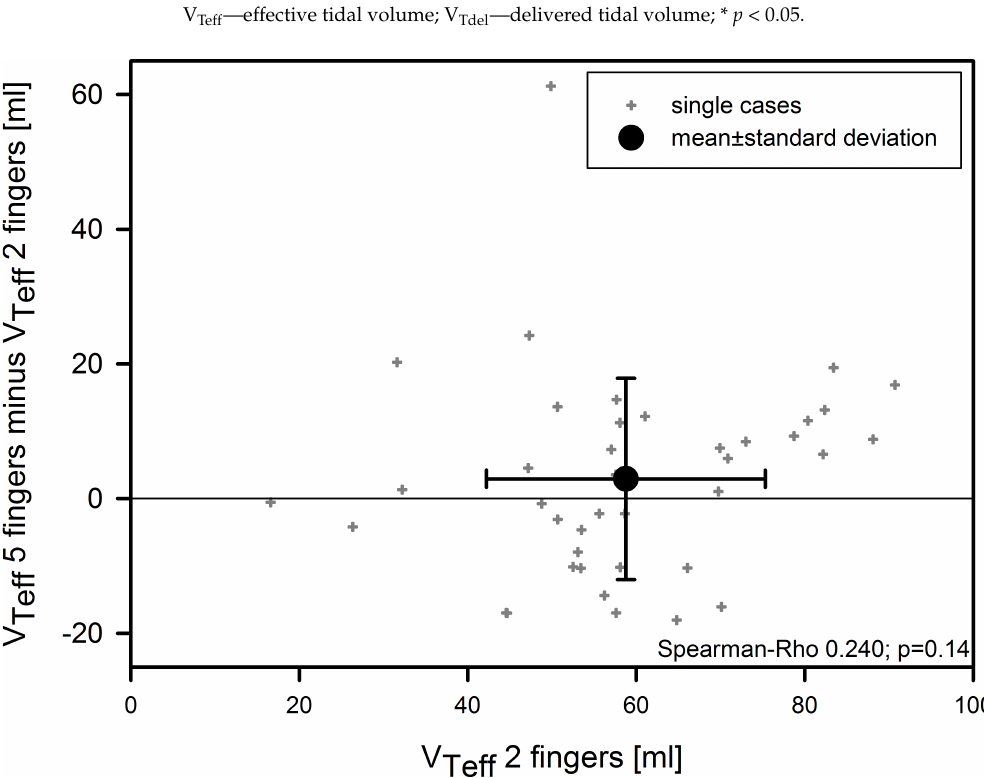
Two-Finger Five-Finger Technique Technique